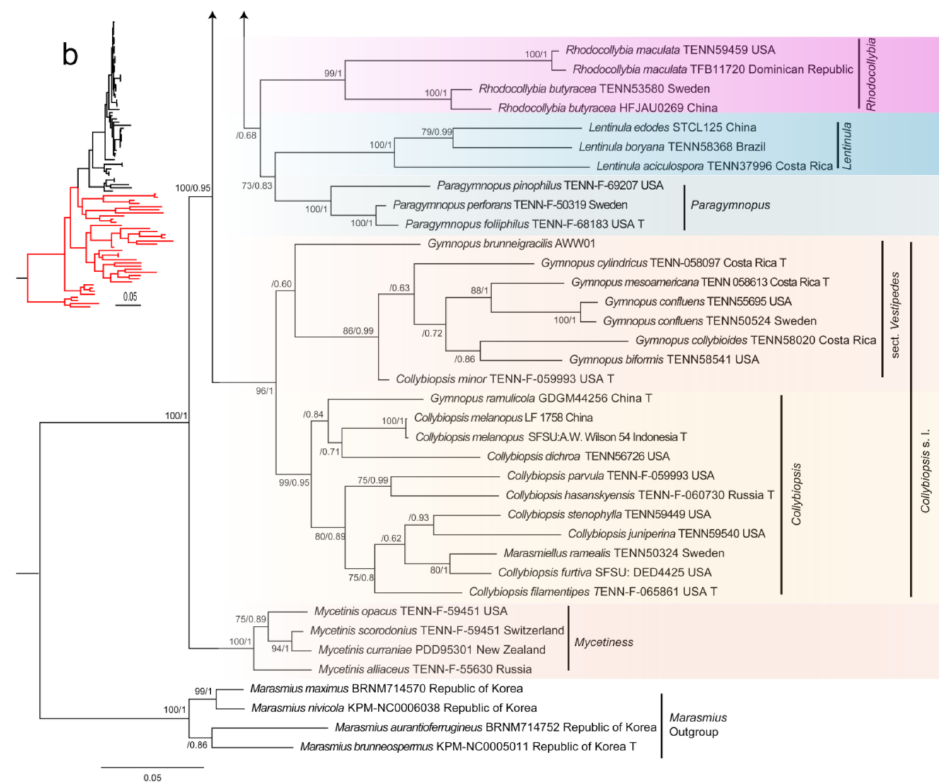
Figure 2. Maximum likelihood phylogenetic tree generated from the ITS and nLSU dataset. Bootstraps values (BS) ≥ 70% from ML analysis and Bayesian posterior probabilities (BPPS) ≥ 0.90 are shown on the branches. Newly sequenced collections are indicated in bold, and the type specimens are denoted by